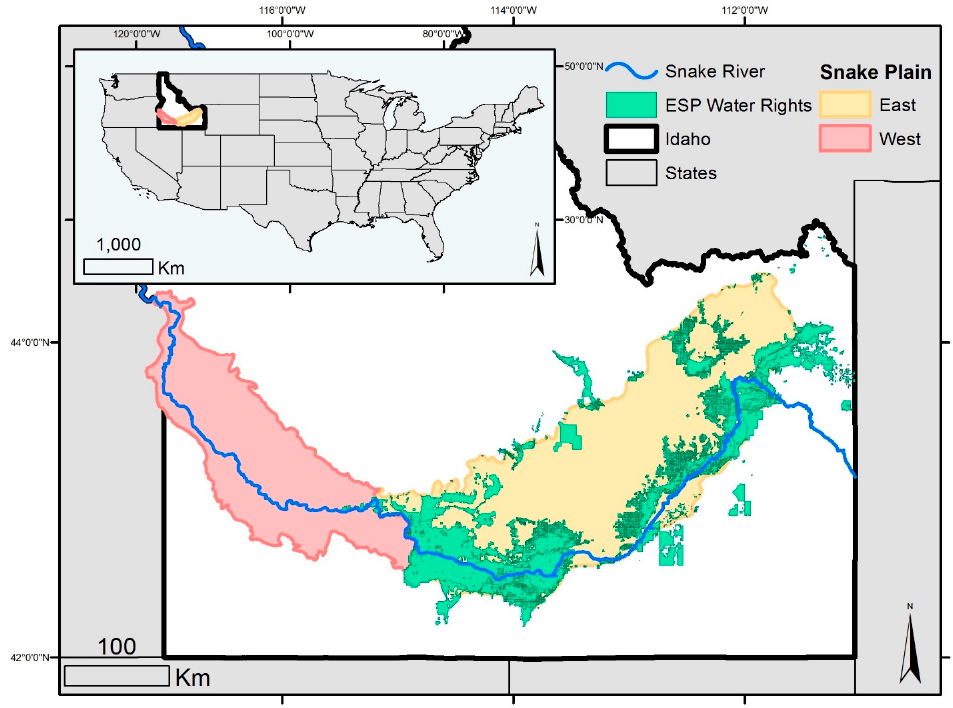
Figure 1. Map of the study region, including water rights for irrigation in the Eastern Snake River Plain.